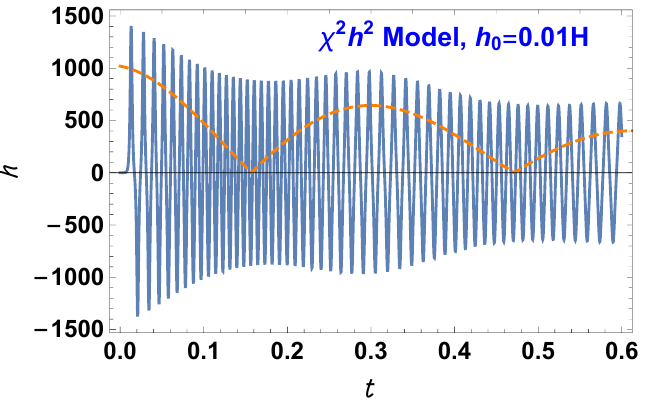
Figure 6 . The Higgs evolution in the model where the Higgs is always in the broken phase and Higgs starts near the top of the potential hill. We set M = 1020 H; m (cid:31) = 10 H; (cid:31) 0 = f and (cid:21) = 1. The dashed orange curve is M j cos( m (cid:31) t ) j